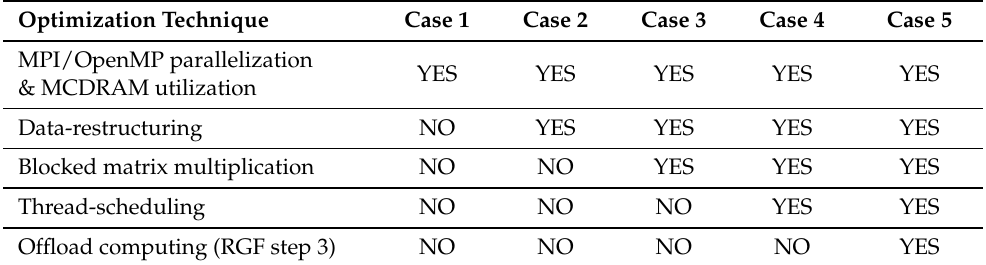
Table 3. Cases of single-node performance tests and techniques used in each case.